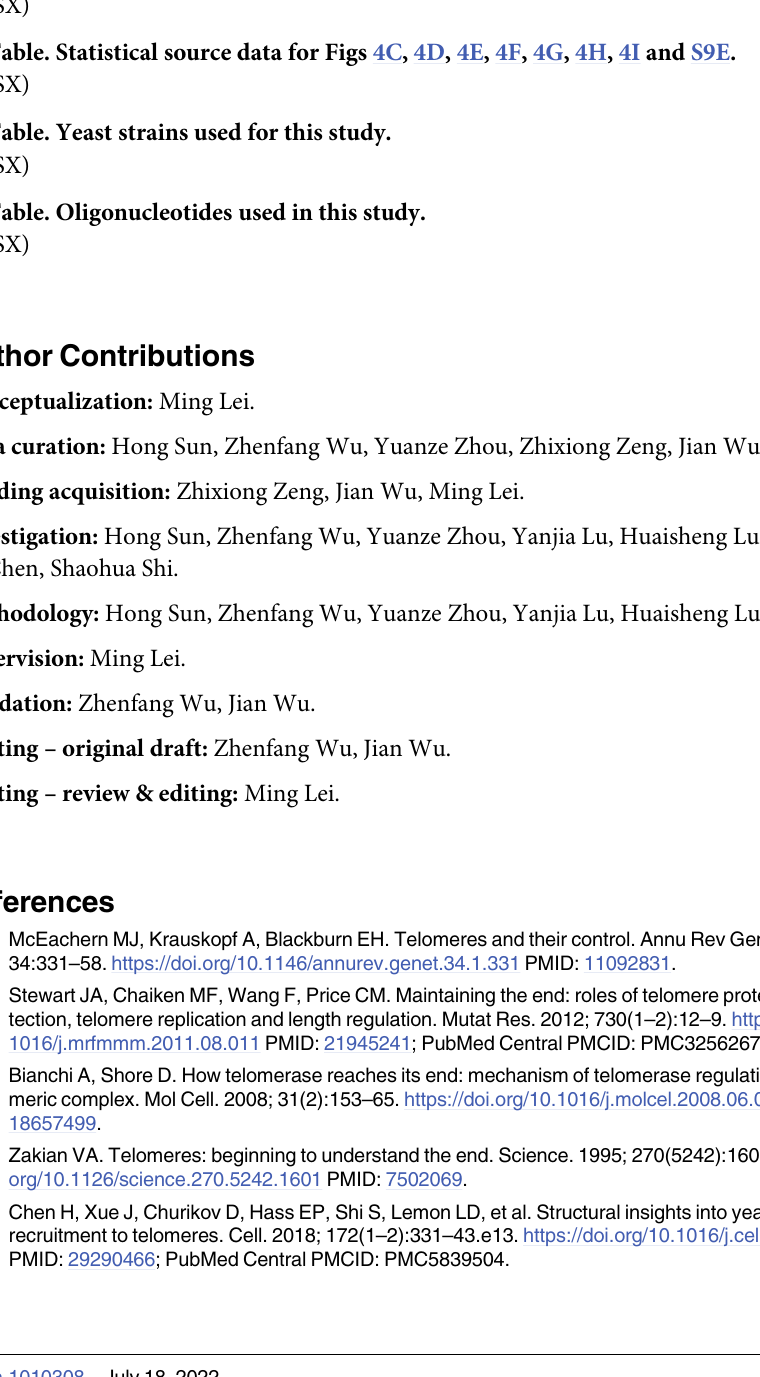
S10 Fig. Architectural model of S . pombe shelterin complex. Ribbon diagrams of the shel- terin complex based on the atomic structures of Pot1 -Tel18, Pot1 -Tpz1 , Tpz1 - DBD OB3 PIM CBM Ccq1 , Rap1 -Poz1-Tpz1 (PDB: 5XXF), Rap1 -Taz1 (PDB: 2L3N) and Taz1 TAD PBM PBM RCT RBM DD (PDB: 4ZMK). Taz1 and Pot1 respectively bind to telomeric dsDNA and ssDNA regions via their Myb domains and OB folds, and are bridged by Rap1, Poz1 and Tpz1 via protein-protein interactions. The dimeric state of the shelterin complex is mediated by Taz1 , Poz1 and the DD (Tpz1 -Ccq1 ) heterotetramer. CBM TAD 2 S1 Table. Crystal data collection and refinement statistics. S2 Table. Statistical source data for Figs 4C, 4D, 4E, 4F, 4G, 4H, 4I and S9E. S3 Table. Yeast strains used for this study. S4 Table. Oligonucleotides used in this